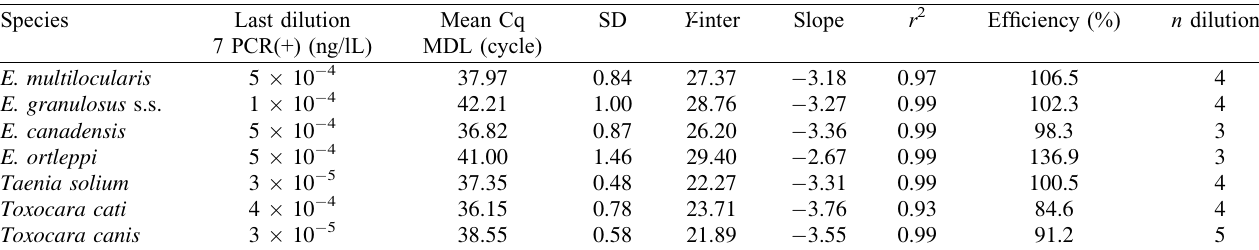
Table 3. Method detection limits performed for each targeted parasite, with DNA dilution series tested on seven PCR assays.